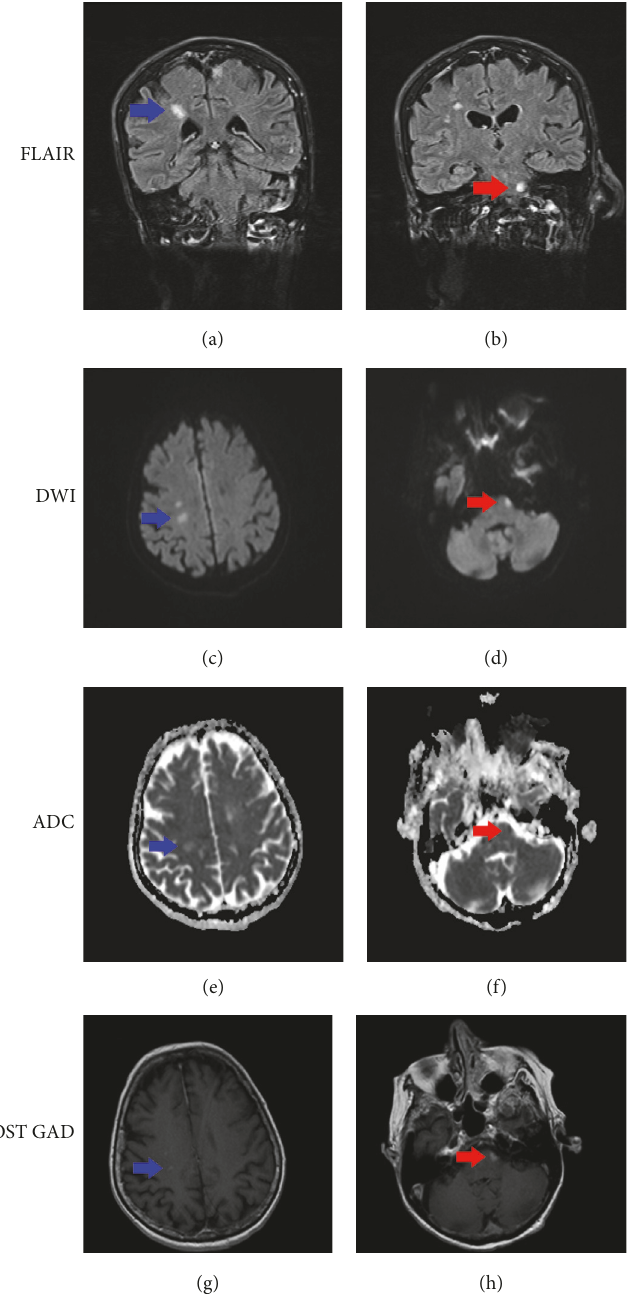
Figure 2: Representative MRI images showing infarcts in the right parietal lobe (blue arrow; images (a), (c), (e), and (g)) and left ventral pons (red arrow; images (b), (d), (f), and (h)). The right parietal lesion shows DWI signal change without corresponding ADC changes, consistent with subacute infarct. The left pontine lesion shows both DWI and ADC signal changes suggesting acute infarct. FLAIR, fluid-attenuated inversion recovery. DWI, diffusion weighted imaging. ADC, apparent diffusion coefficient. T1 POST GAD, T1 postgadolinium.